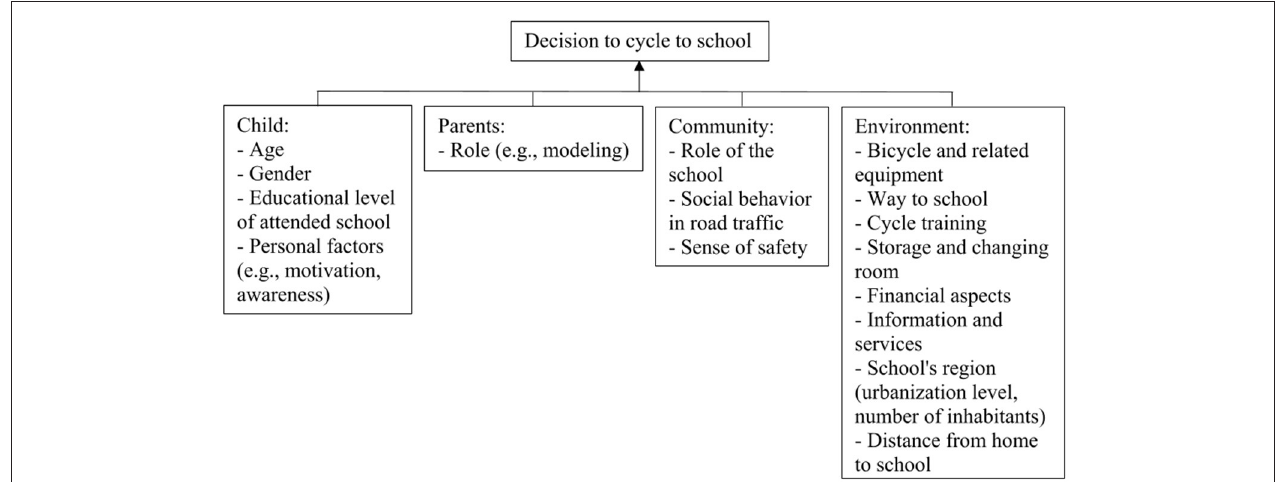
FIGURE 2 | Logic model of the problem: Factors that influence cycling to school based on concept mapping (5,